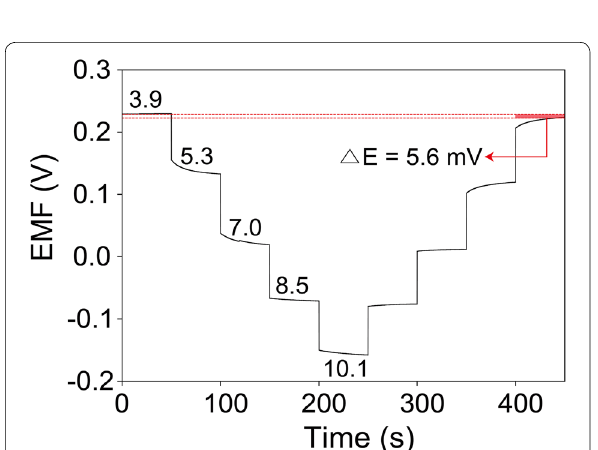
Fig. 4 Temporal EMF response in titration from pH 7.0 to pH 8.5 for pH sensor